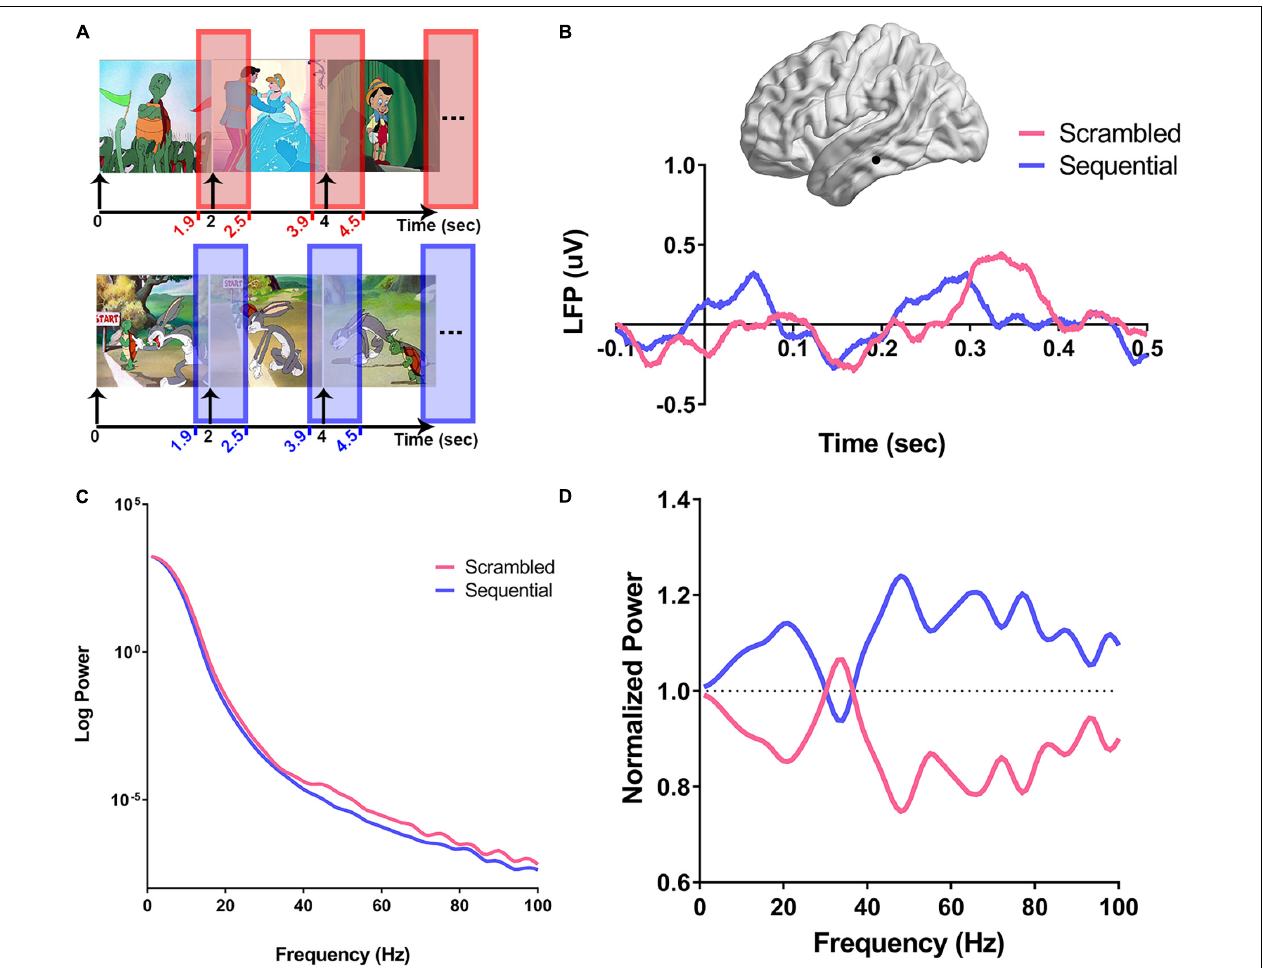
FIGURE 2 | Computation of power spectra in response to scrambled vs. sequential images. For each recording site, the normalized power spectra were calculated as shown in (A–D) . (A) For each experimental condition (Scr in pink and Seq in blue), the time window around the onset of the image (100 ms before onset to 500 ms after onset of stimulus) was used to calculate the average normalized power spectra. (B) An example using a recording site from the left inferior temporal gyrus (ITG) from subject three (S3) is illustrated on a brain surface reconstruction in MNI space. The average variation of the amplitude of local field potentials over time in response to scrambled (pink), and sequential (blue) peri-stimulus onset is shown. Onset of the stimulus is defined as time zero, and all single trials were preprocessed by subtracting a baseline offset calculated by averaging the amplitude of signal for each trial between − 0.1 and 0.05 s. (C) Peri-stimulus PSDs from the single left ITG recording site are shown in (B) . For each trial of the experimental conditions (Scr and Seq), power spectra were derived after z -scoring the corresponding time domain signals. The average power spectral density (PSD) for each condition is log-transformed and shows a clear broadband increase over a wide range of frequencies in the power response to Scr vs. Seq. (D) Single-trial PSDs are then normalized by dividing by the average of all trials PSDs for the studied recording site, and the average of each condition-specific normalized PSDs is